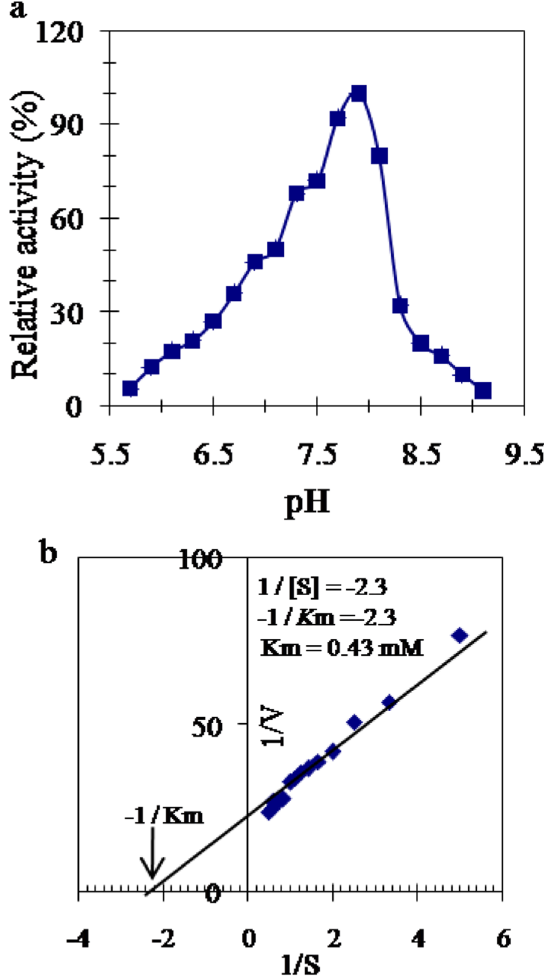
Fig. 3 a The pattern of TLGST pH profile utilizing 0.1 M potassium phosphate (5.7–8.0) and Tris–HCl (8.0–9.2). b Lineweaver–Burk plot of TLGST reaction speed in response to CDNB